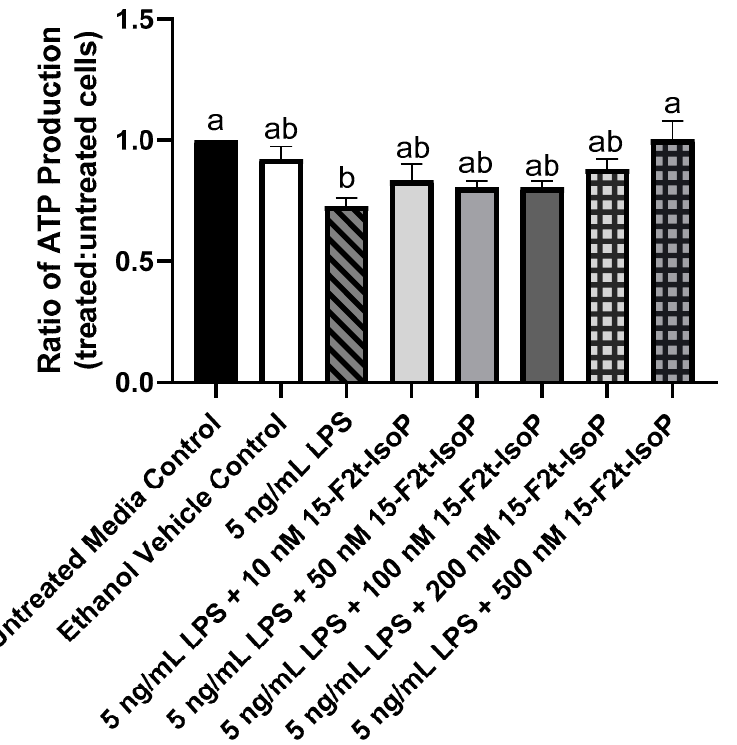
Figure 3. ATP production in RAW 264.7 macrophages ( n = 7) is altered by 15-F 2t -isoprostane during endotoxin challenge. Statistical analyses included a one-way ANOVA with Tukey’s HSD posthoc test. endotoxin challenge . Statistical analyses included a one-way ANOVA with Tukey’s HSD posthoc a,b Different superscripts are different ( p < 0.05). LPS—lipopolysaccharide; test. a,b Different superscripts are different ( p < 0.05). LPS—lipopolysaccharide; IsoP—isoprostane.